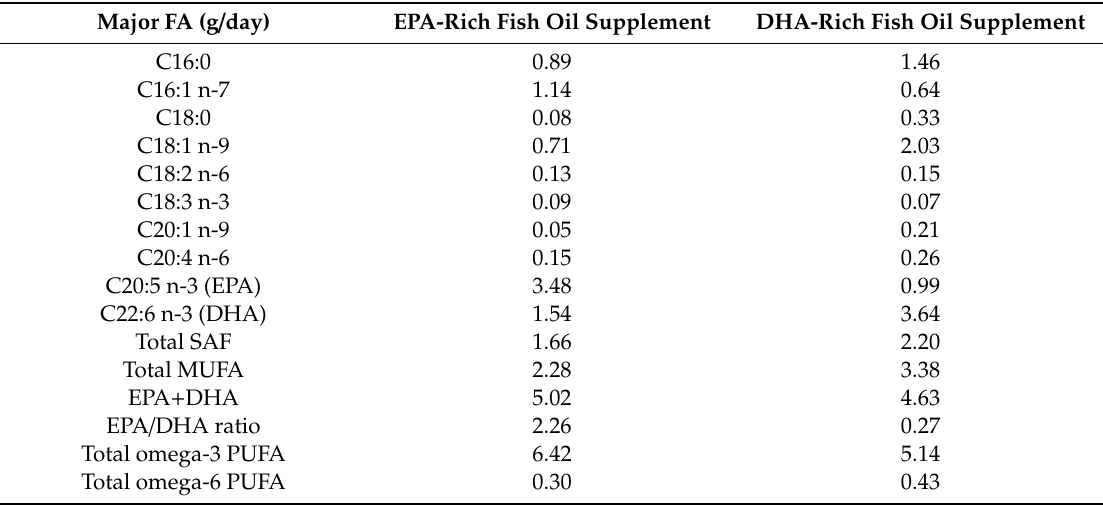
Table 1. Fatty acid content per day of EPA-rich or DHA-rich fish oil supplement. Major FA (g /